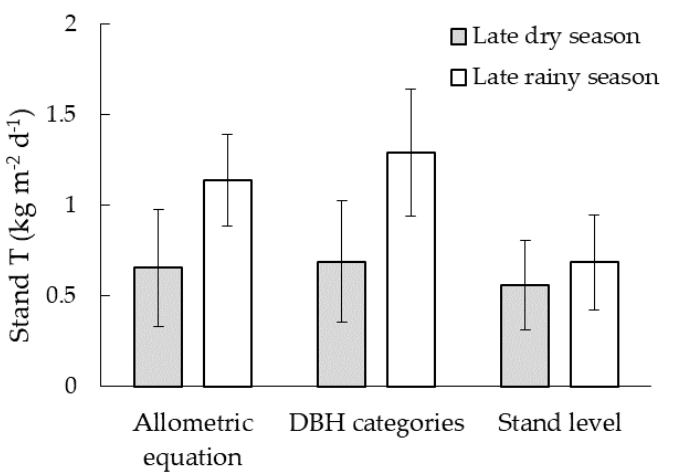
Figure 3. Summary of stand transpiration (kg water m –2 d –1 ) in the tropical dry deciduous forest at El Palmar, Yucatan, Mexico, using three methods. The late dry season corresponds to